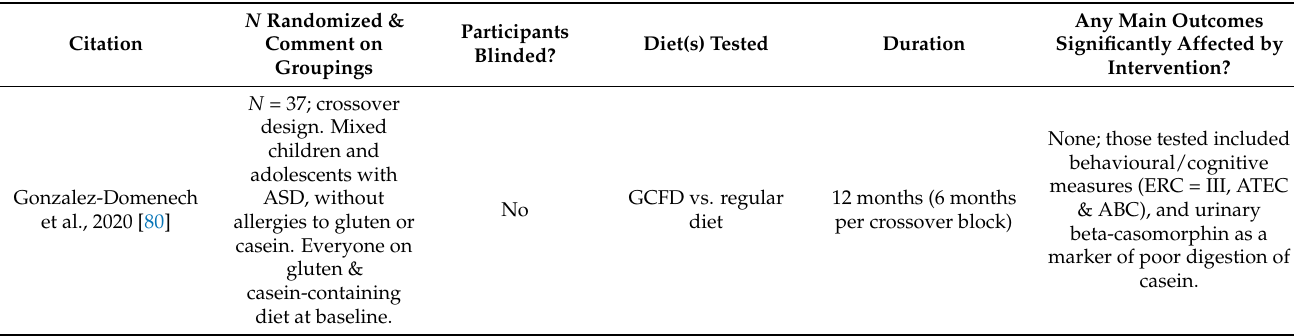
Table 2. A summary of randomised trials which have in some way included a gluten-free diet as an intervention in treating